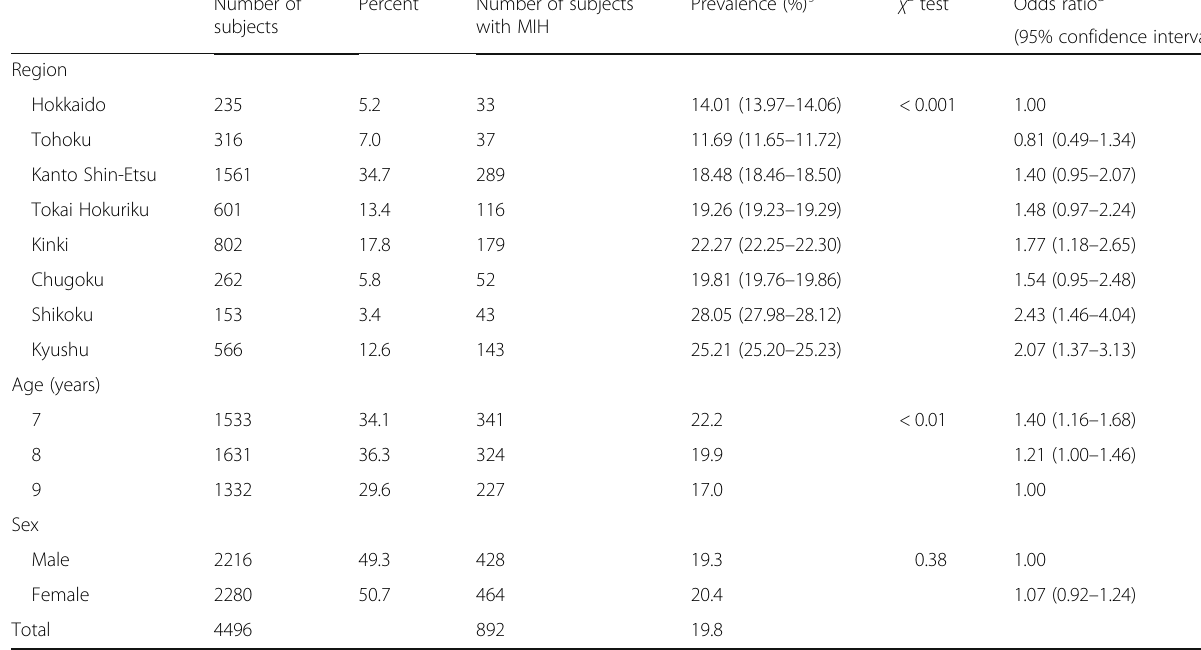
Table 1 Distribution of MIH in areas throughout Japan and age- or sex-specific prevalence of MIH Number of subjects